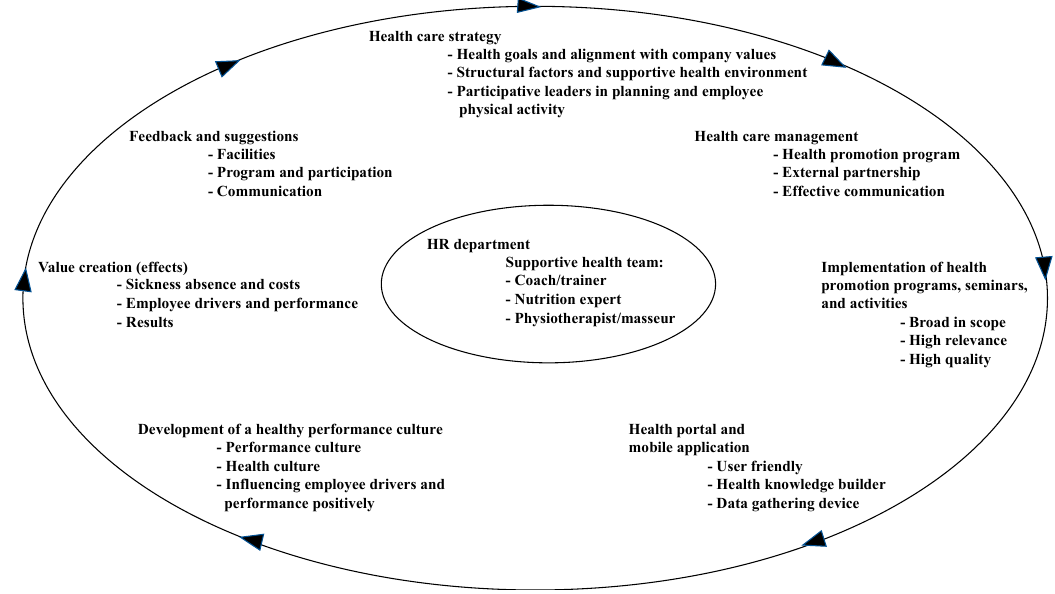
Figure 2. The implementation of a health-promoting performance culture.